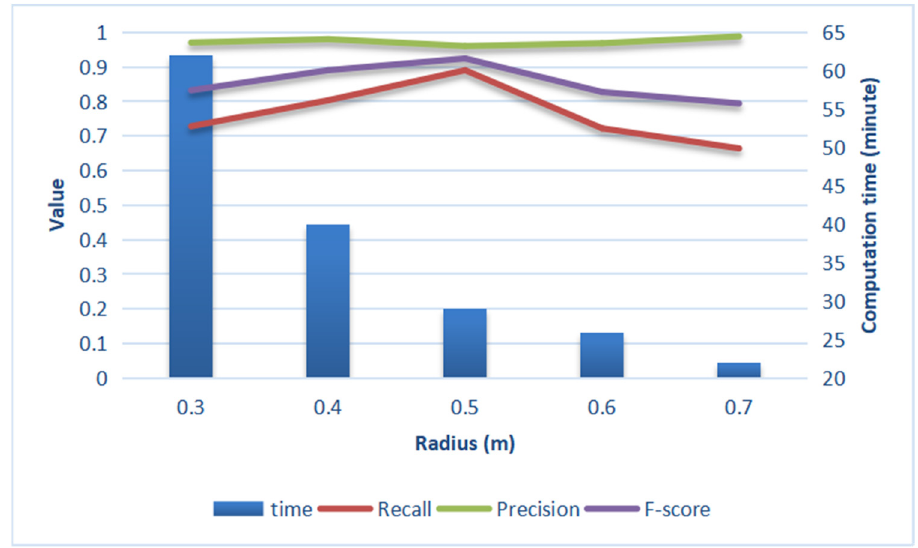
Figure 13. The value change trend of three indices (recall, precision, and F-score) and computation time with the variation of the parameter radius.